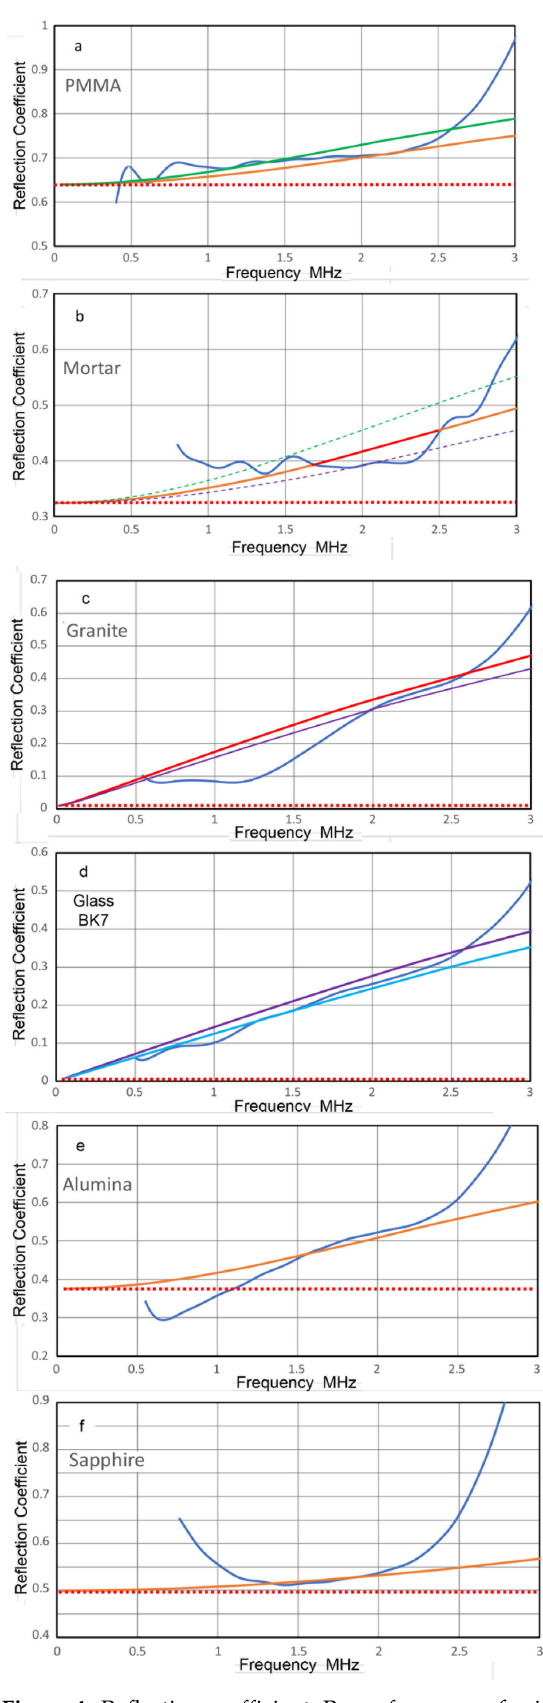
Figure 4. Reflection coefficient, R, vs. frequency, f, with glass buffer using BS and IF signals (blue curve) and calculated R th using Equation (2) (red dotted line). ( a ) PMMA sample. Additionally, shown by orange and green curves are calculated R th using Equation (4) with couplant thicknesses of 35 and 45 μ m. ( b ) Mortar sample without entraining agent, plus R th with Equation (4) for couplant